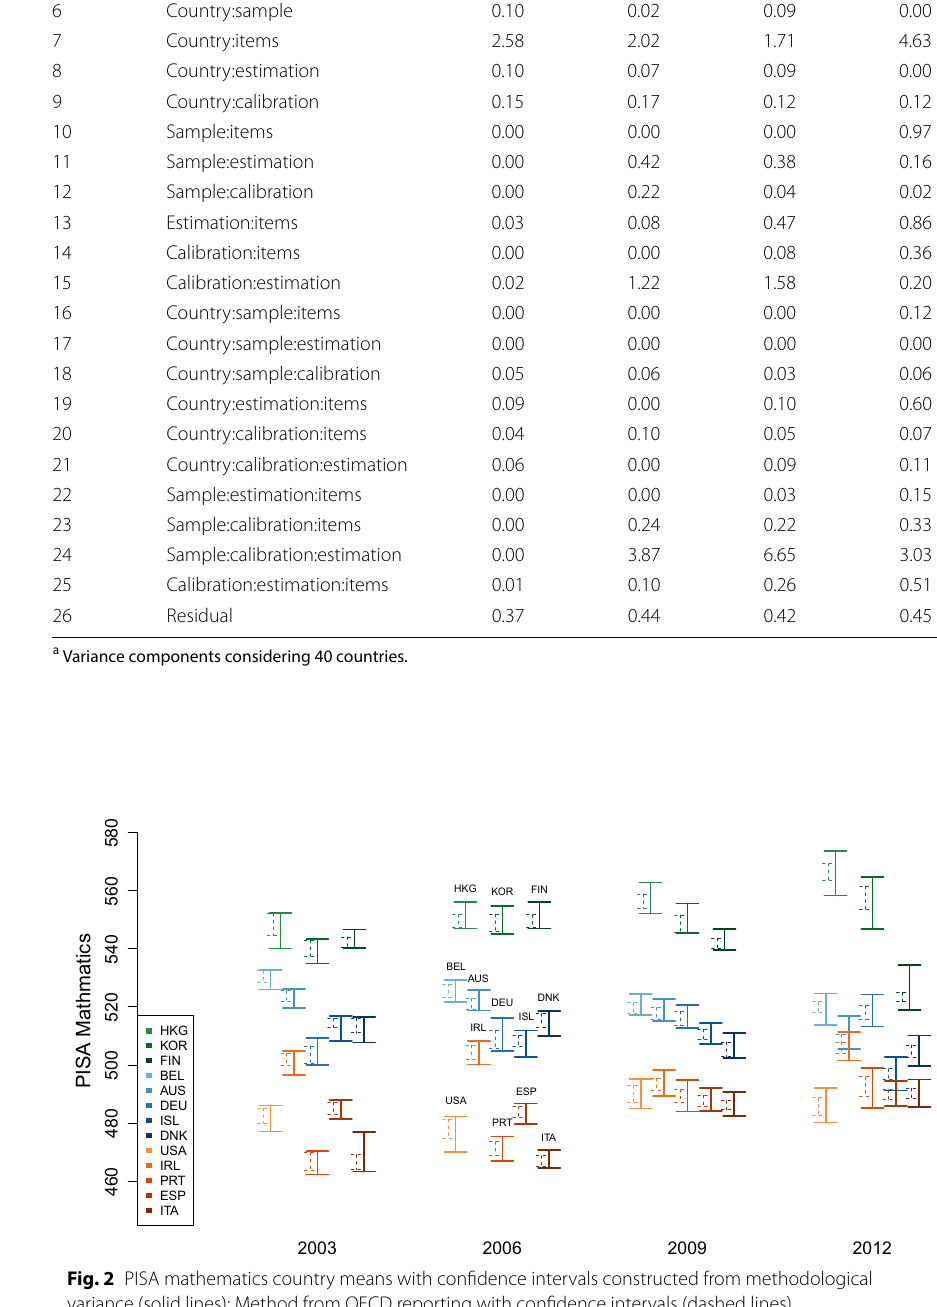
Fig. 2 PISA mathematics country means with confidence intervals constructed from methodological variance (solid lines); Method from OECD reporting with confidence intervals (dashed